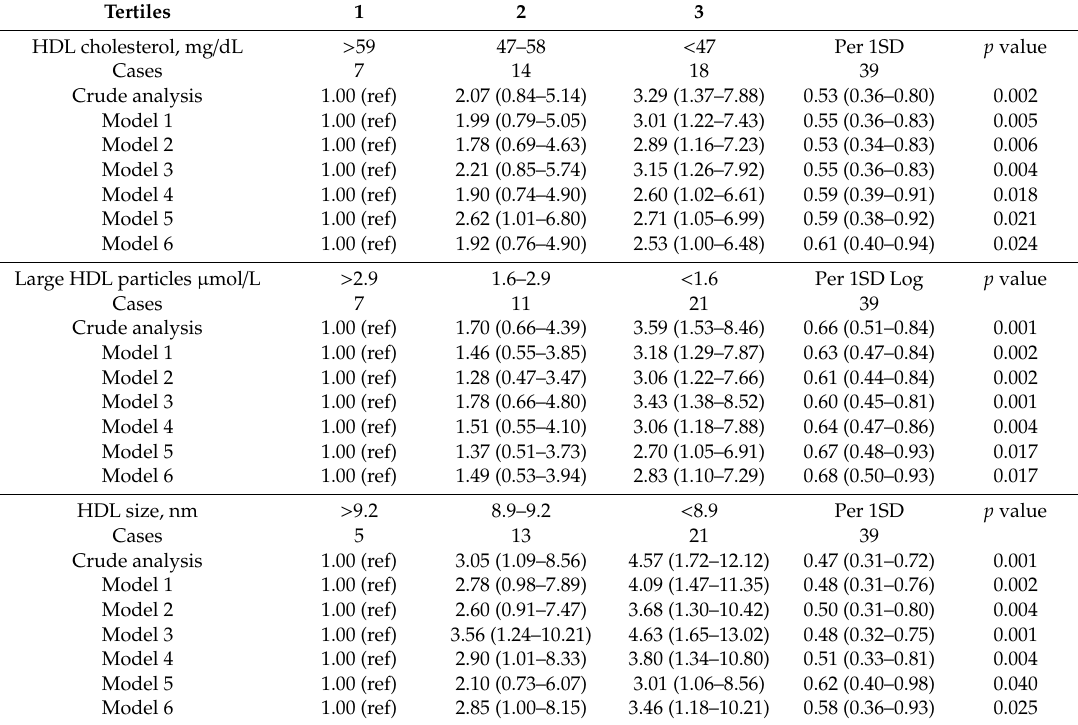
Table 3. Association between HDL parameters and risk of PTDM in 351 RTRs. Tertiles